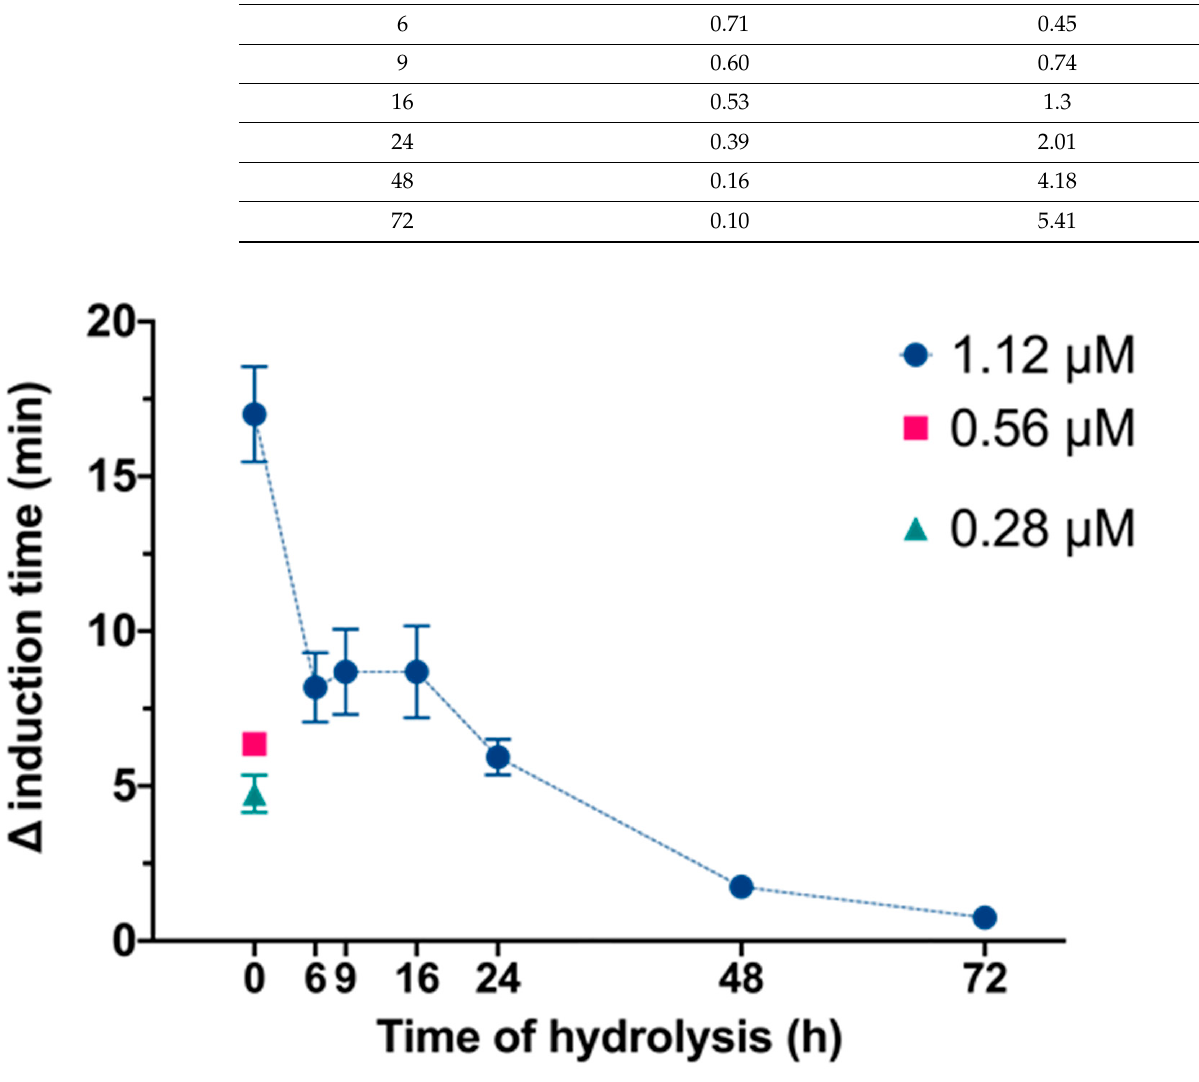
Figure 2. Effect of different InsP 6 concentrations and InsP 6 hydrolysates (6 to 72 h) on the increase in the time needed for the induction of CaOx crystallization in synthetic urine. The InsP 6 levels were 1.12, 0.56 or 0.28 µ M for non-hydrolyzed InsP 6 (0 h), and the total InsPs level was 1.12 µ M for hydrolyzed samples. Values are expressed as mean ± SE of three experiments.